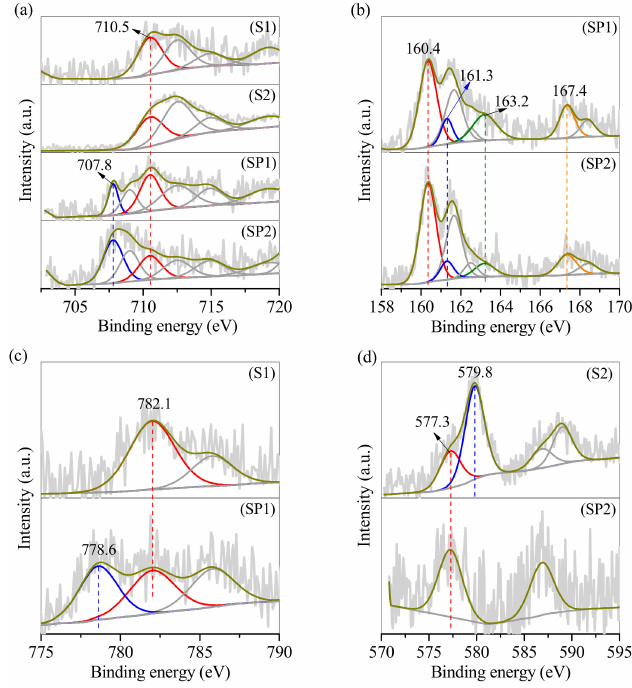
Figure 3. High resolution ( a ) Fe 2p, ( b ) S 2p, ( c ) Co 2p and ( d ) Cr 2p X-ray photoelectron spectroscopy (XPS) curves of S1, S2, SP1 and